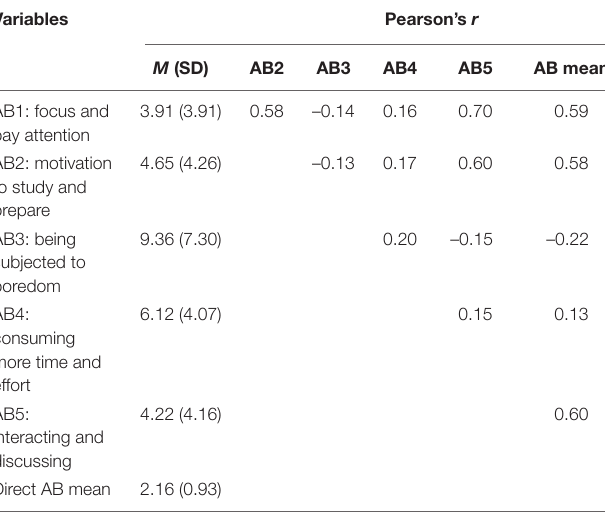
TABLE 4 | Descriptive statistics and correlations of attitude toward behavior (AB) for the FLL group ( n =